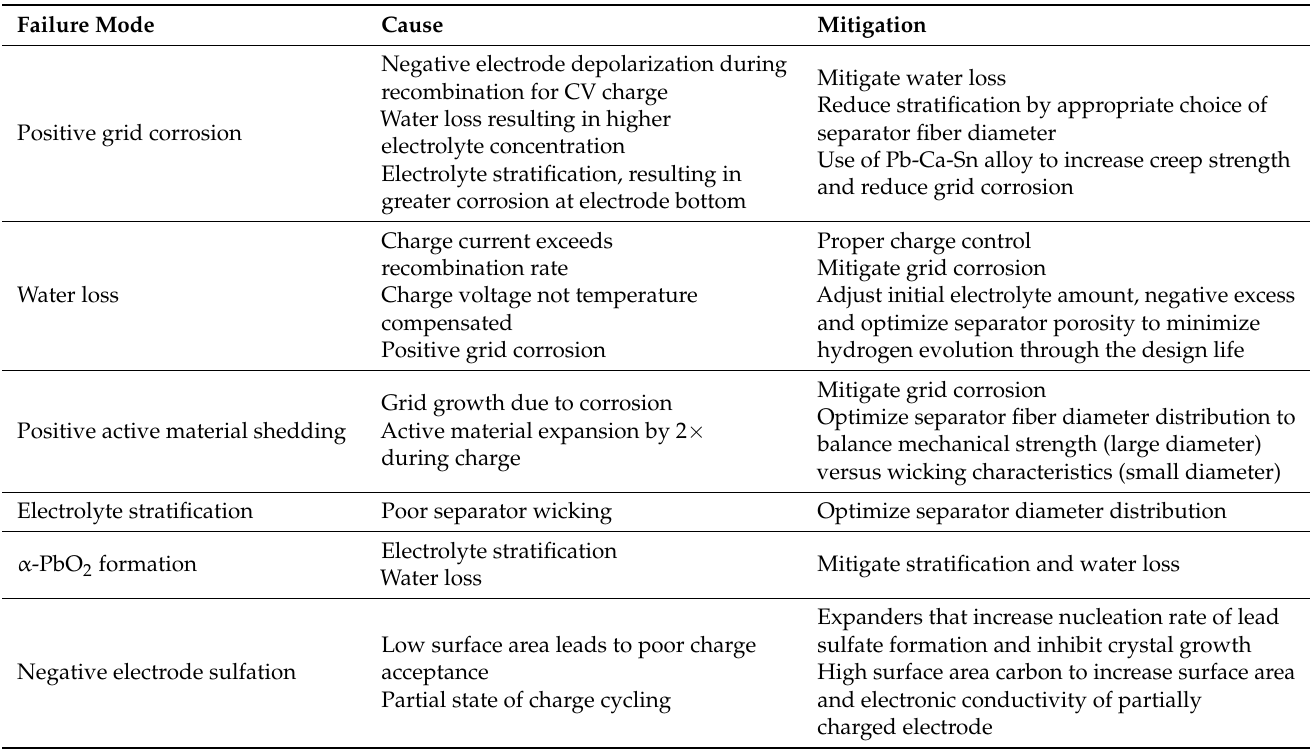
Table 1. Failure Modes of Absorbed Glass Mat Valve Regulated Lead Acid